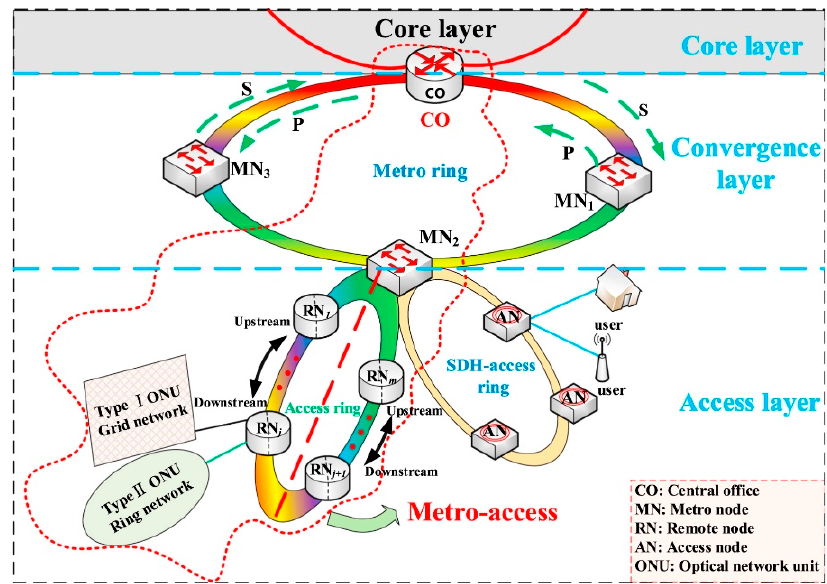
Figure 3. Diagram of network architecture of differential protection with optical fiber communica- tion lines [58]. lines